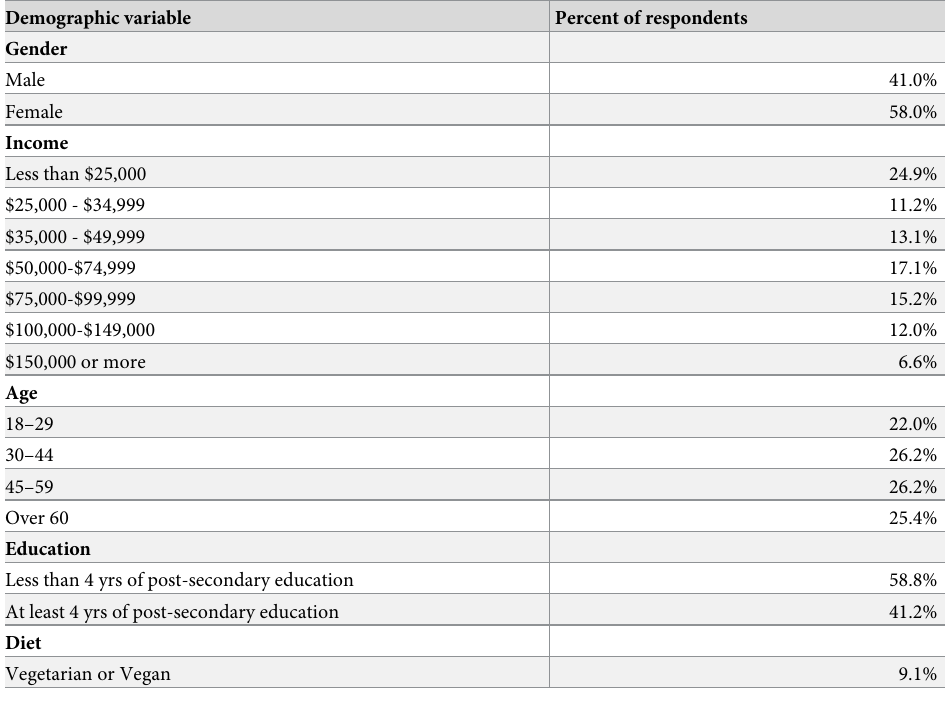
Table 1. Demographics of the survey participants (n =